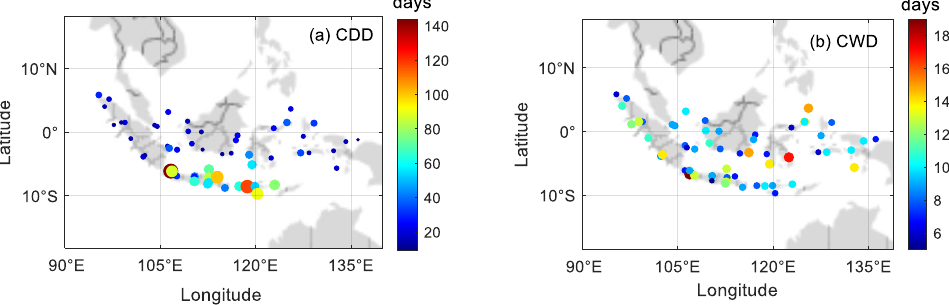
Figure 5. The mean value of precipitation-duration-based indices including CDD ( a ) and CWD ( b ), for 63 of BMKG stations in the IMC during 2016 to 2020.